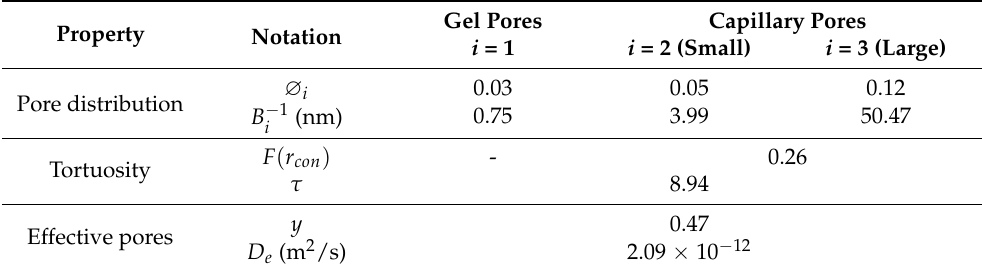
Table 1. Material parameters derived from pore structure